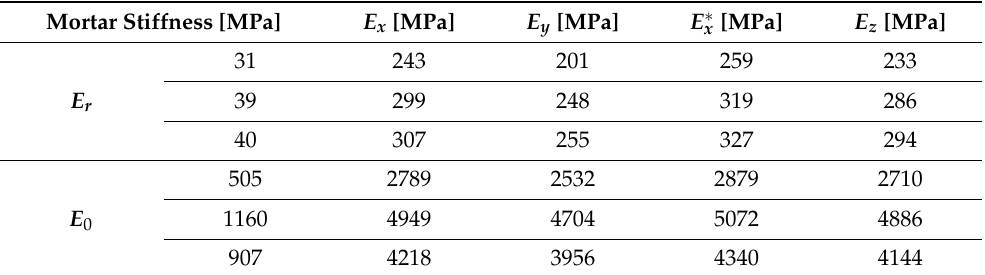
Figure 11. The values of the effective stiffness moduli determined for particular directions for different mortar material parameters ( ν = 0.4): ( a ) for relaxed moduli, and ( b ) for initial moduli.